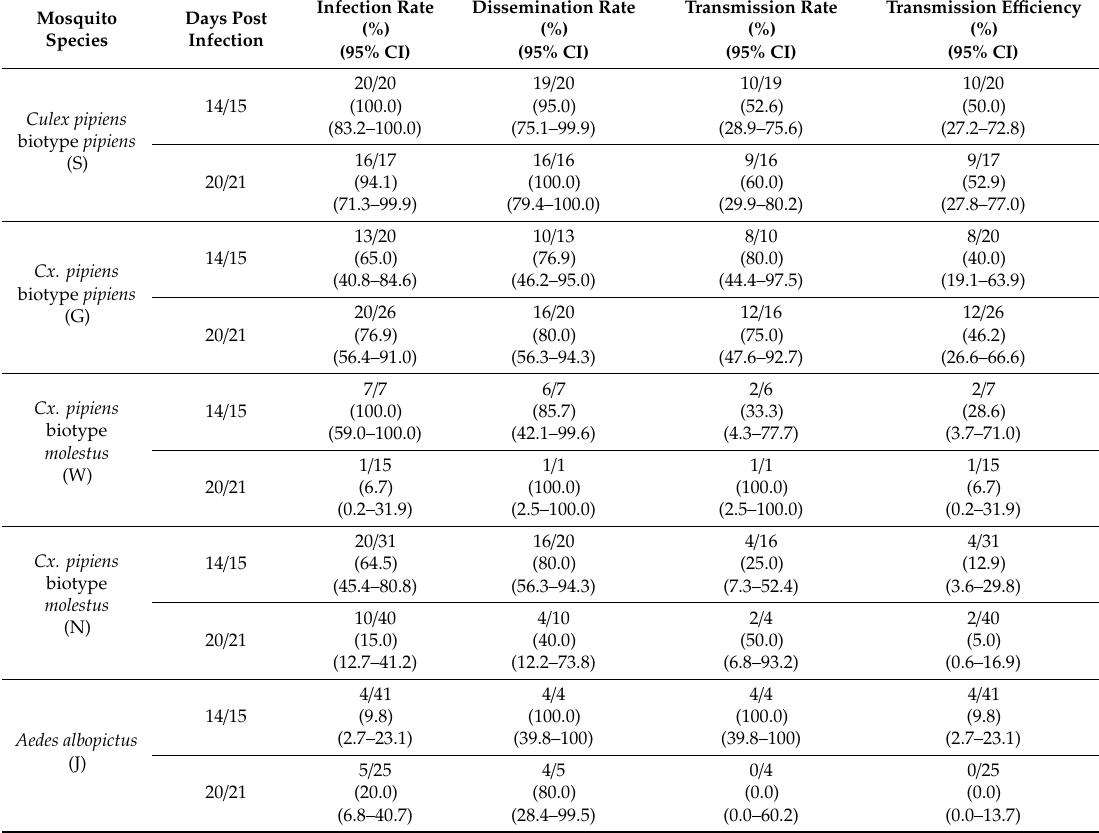
Table 3. Infection, dissemination, and transmission rates and transmission e ffi ciencies 14 / 15 and 20 / 21 days post infection at an incubation temperature of 25 ◦ C. CI stands for confidence